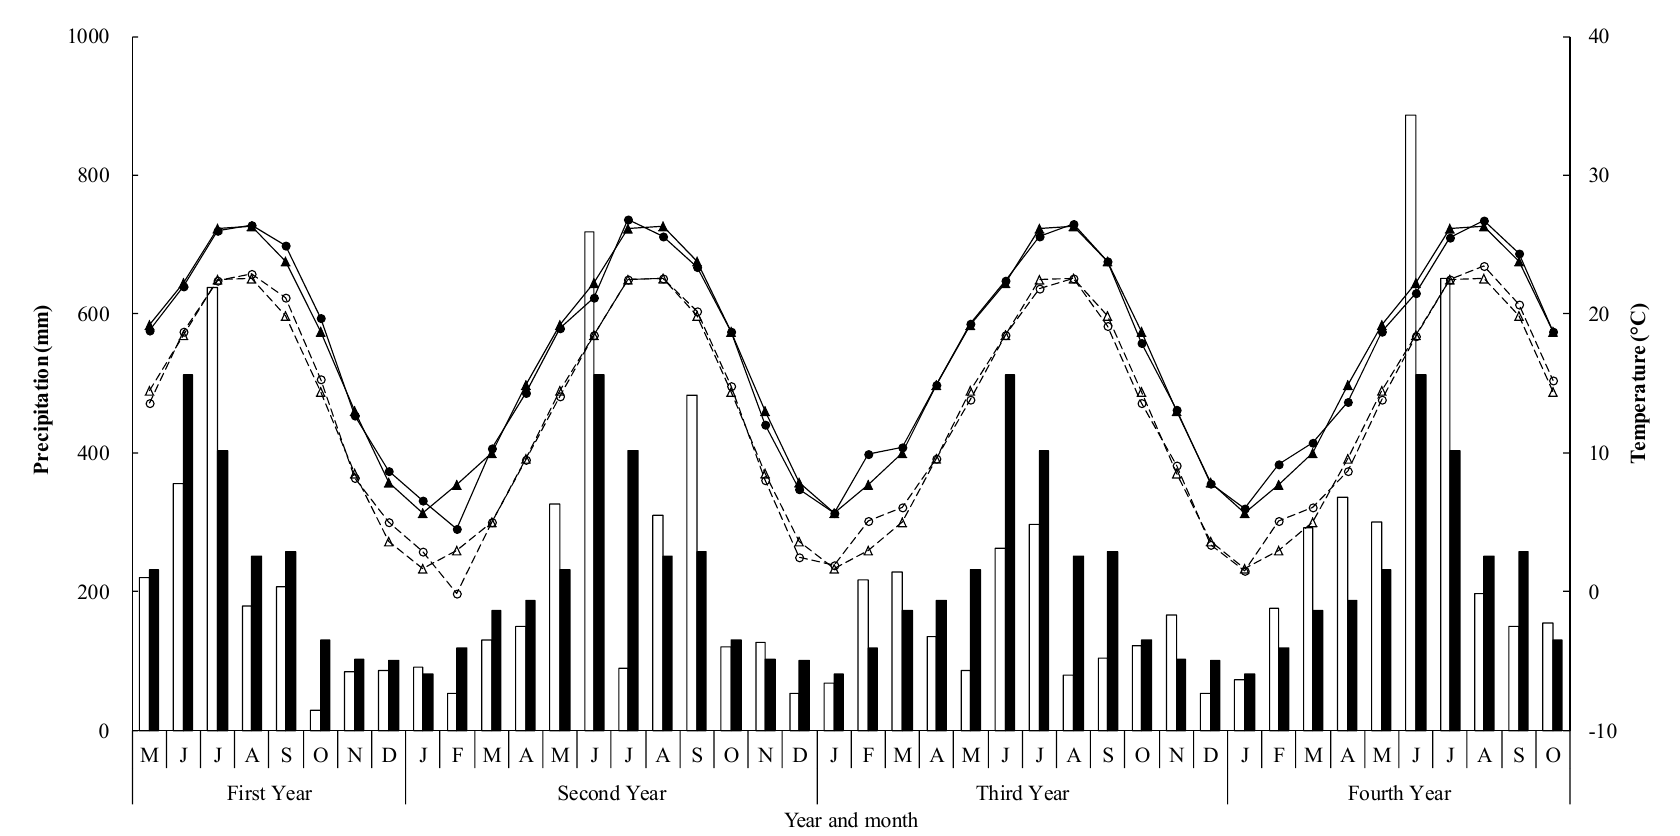
Figure 4. Monthly precipitation in the experimental period ( □ ) and long ‐ term average ( ■ ), monthly mean of daily mean temperature in the experimental period ( ● ) and long ‐ term average ( ▲ ), and monthly mean of minimum temperature in the experimental period ( ○ ) and long ‐ term average ( ∆ ). The experimental period was 2007 ‒ 2010; long ‐ term period was 2000 ‒ 2010. As for the abbreviation of the month, M, J, J, A, S, O, N, D, J, F, M and A are May, June, July, August, September, October, November, December, January, Februay, March, and April, respectively. Table 4. N uptake (g m − 2 ) by DL Napiergrass and IR under different fertilizer treatments in 2007 ‒ 2010.